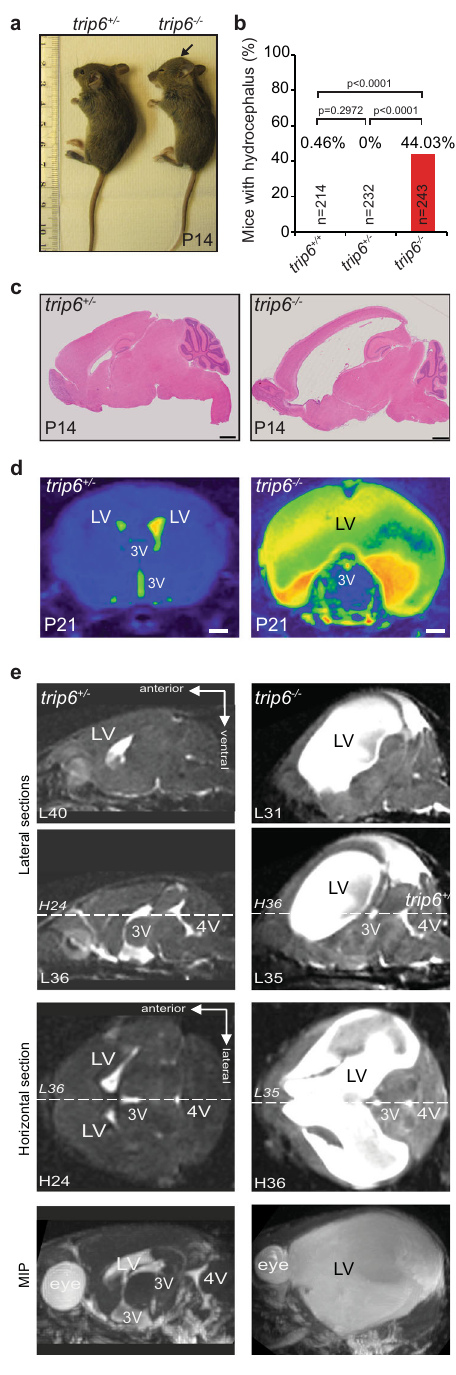
Fig. 2 trip6 deletion causes perinatal hydrocephalus. a Macroscopic view of cranial malformation indicative of hydrocephalus (arrow) in a trip6 − / − mouse (unaffected trip6 + / − littermate shown for comparison). b Quanti fi cation of hydrocephalus incidence in control and trip6 − / − mice. n number of mice assessed ( p < 0.0001, two-tailed chi squared test; see also Methods and Supplementary Table 5). Source data are provided as a Source Data fi le. c H&E stained sagittal brain sections showing enlarged LVs in a trip6 − / − mouse (unaffected trip6 + / − littermate shown for comparison). d Coronal brain MRI images from control and hydrocephalic mice at the level of lateral (LV) and 3rd ventricle (3V) demonstrate the enlargement of LV, but not 3V, in the trip6 − / − mouse. In the colorized heat maps the fl uid- fi lled ventricles appear yellow. e Lateral ( “ sagittal ” ) (L) and horizontal (H) brain MRI sections and lateral view of a maximum intensity projection (MIP) reconstruction depicting the ventricular system (white) in mice of the indicated genotypes (P21). Dashed lines (L and H) indicate the section planes of lateral and horizontal views, respectively. The LV is seen only in L40 and not in L36 in the wt. In control, LV, vs. 3V and the 4th ventricle (4V) can only be visualized in separate lateral sections (L40, L36) while the LV of trip6 − / − encompasses several sections (L31, L35). In contrast to LV, the 3V and 4V are not enlarged. The MIP views show the entire ventricular system. Note the massive expansion of the ventricular system in trip6 − / − compared to the heterozygote. Scale bar: 1 mm ( c , d ). For 3D reconstruction of the complete set of sections, please see Supplementary Movies 1 and